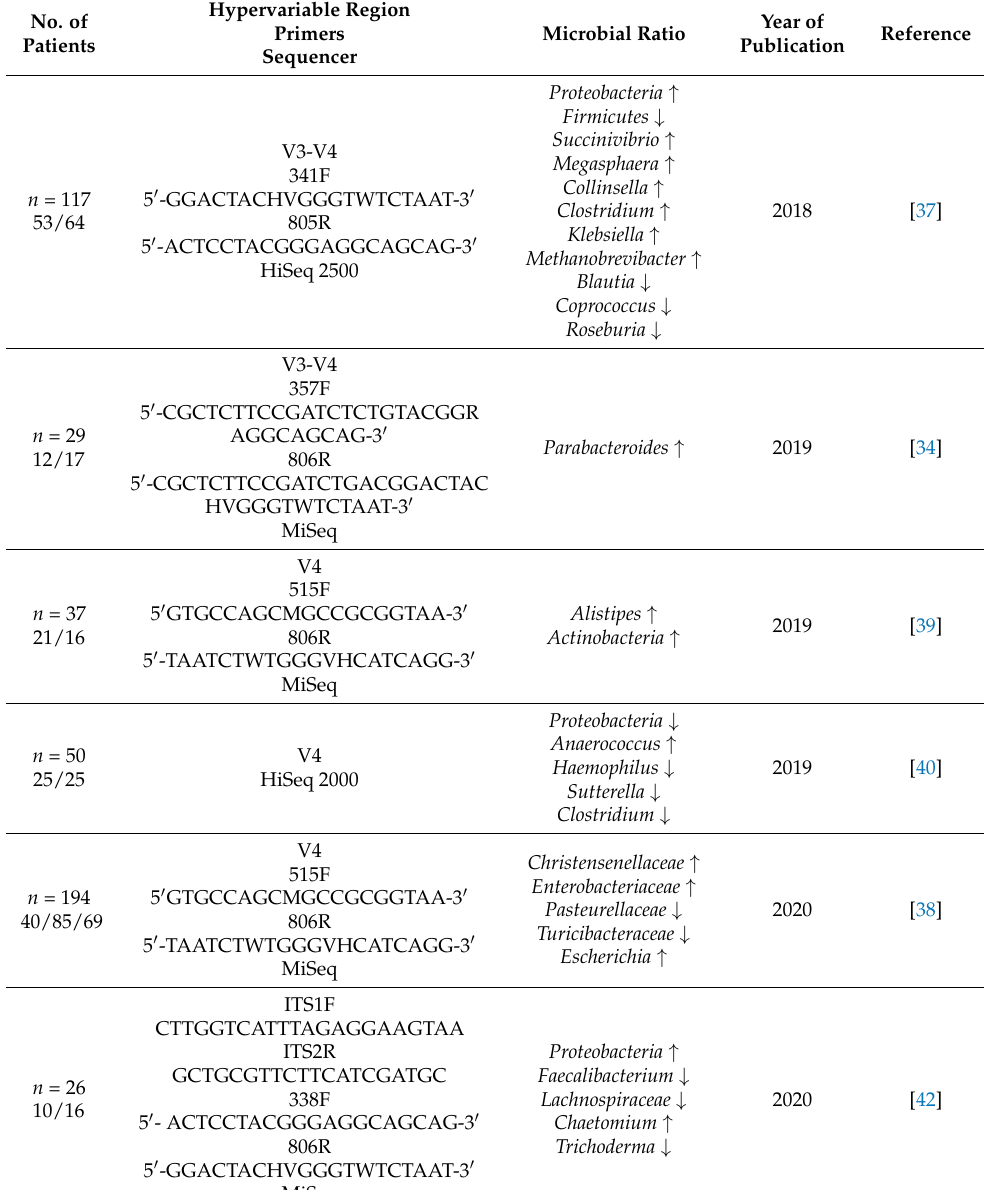
Table 1. Summarizing overview of the main microbial alterations that occur in SCZ. No. of